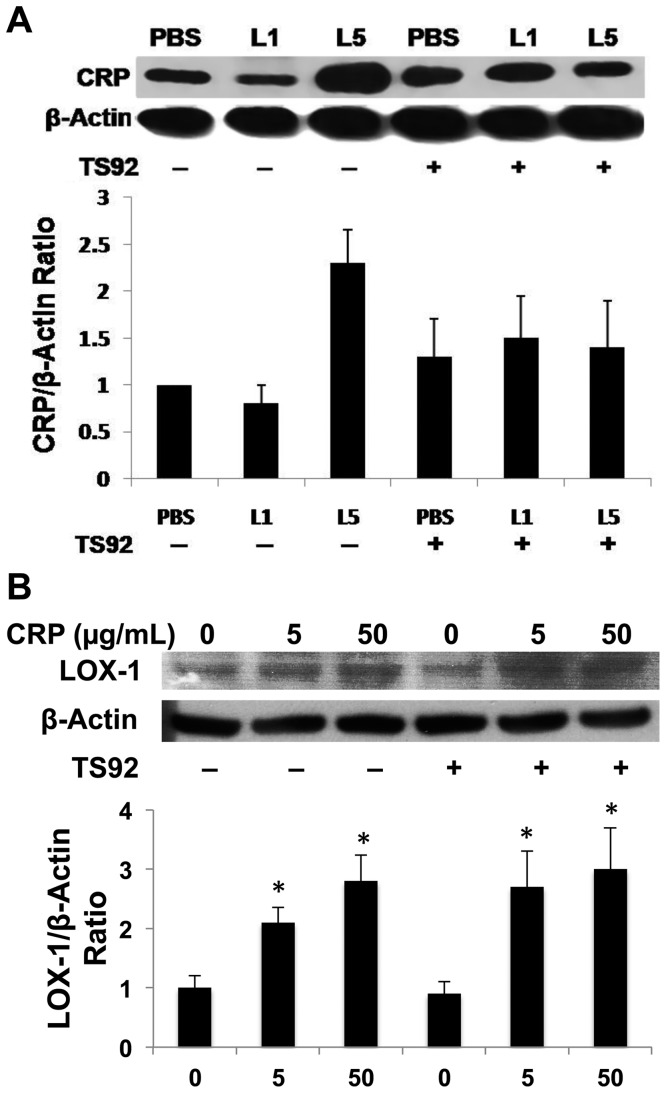
Effects of lectin-like oxidized LDL receptor-1 (LOX-1) inhibition in human aortic endothelial cells (HAECs).(A) HAECs were pretreated with LOX-1 neutralizing antibody TS92 before the introduction of L1 or L5 into cell culture. (B) HAECs were pretreated with TS92 before the introduction of recombinant human CRP (5 or 50 µg/mL) into cell culture. For all experiments, n = 3, and bars shown in graphs represent standard deviation. *P<0.05 vs. untreated control.